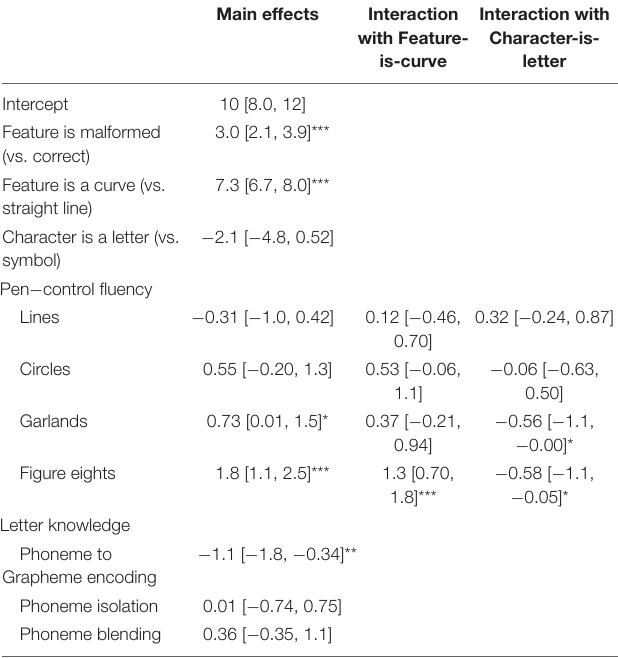
TABLE 3 | Pen-movement disfluency (velocity peak count) when copying